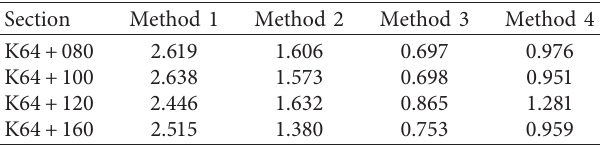
Table 4: Comparison of safety factors calculated by using the four methods.